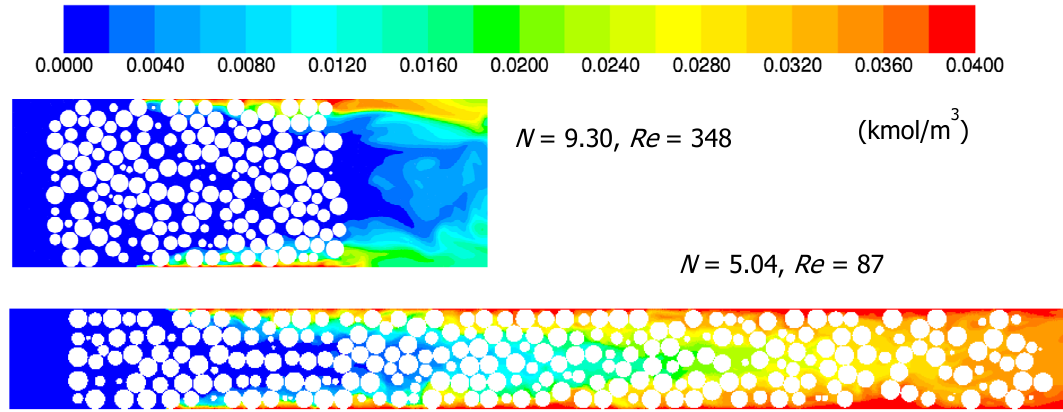
Figure 5. Full bed methane molar concentration (kmol/m 3 ) contour plots on a slice through the midplane of two particle beds, for N = 5.04 and N = 9.30. The direction of flow for the two views is left to right.